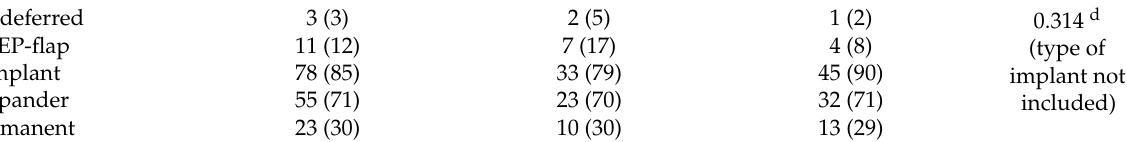
Table 1. Patient and tumor characteristics in the overall study